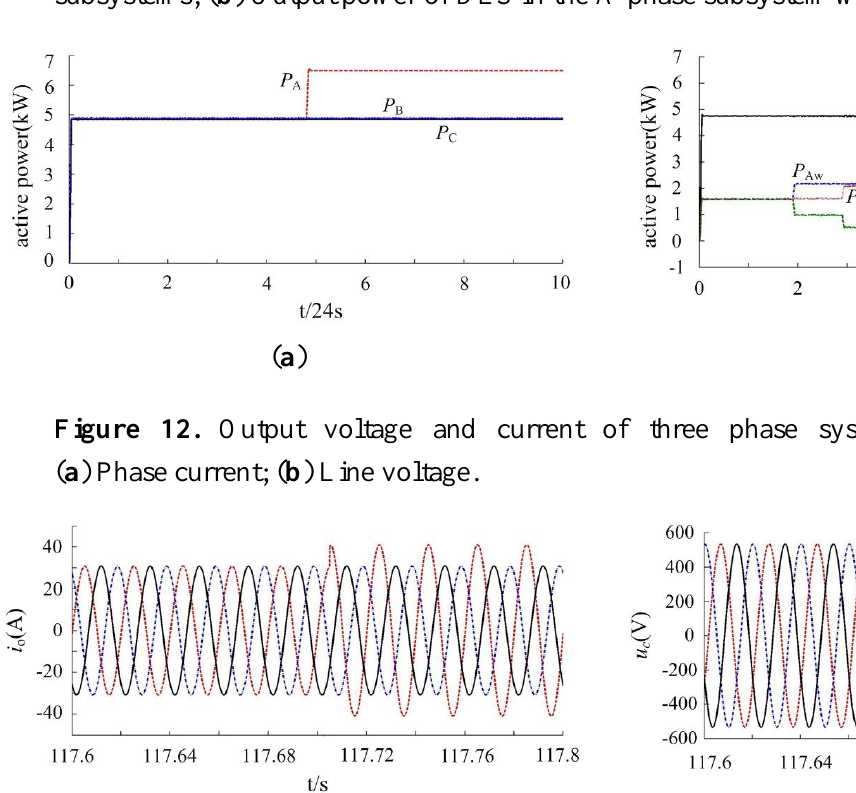
Figure 11. Output of the three-phase series micro-grid. ( a ) Output power of A, B, C phase subsystems; ( b ) Output power of DES in the A-phase subsystem with an emergency.